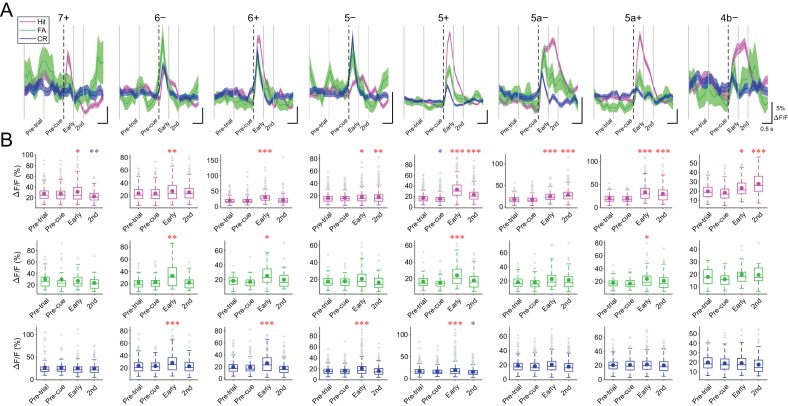
Task-related CF signals in all the compartments.(A) ROI-averaged ΔF/F traces from single compartments in single trials were classified by trial types and averaged across sessions and animals. Thick colored lines represent mean and the shadings represent s.e.m. Vertical dashed lines represent cue onset, and gray solid lines represent the edges of response windows. (B) Averaged ΔF/F value within each response window per trial for each trial type pooled across sessions and animals ( 7+, n = 5 mice, 195, 30, and 155 trials for hit, FA, and CR trials; 6−, n = 6 mice, 305, 41, and 245 trials; 6+, n = 10 mice, 345, 39, and 261 trials; 5−, n = 12 mice, 555, 66, and 452 trials; 5+, n = 12 mice, 644, 78, and 553 trials; 5a−, n = 10 mice, 516, 70, and 454 trials; 5a+, n = 3 mice, 304, 49, and 302 trials; 4b−, n = 2 mice, 112, 19, and 120 trials). Colored dots represent means and gray crosses represent outliers. Asterisks represent significantly positive (red) or negative (blue) differences compared with pre-trial ΔF/F. One-way ANOVA with repeated measures followed by post-hoc Tukey’s test: *p<0.05, **p<0.01, ***p<0.001. (A,B) Only trials without appreciable licking (lick rate <1 Hz) during pre-trial period are included in the analyses.10.7554/eLife.47021.023Figure 4—figure supplement 1—source data 1.Datasets used to create Figure 4—figure supplements 1 and 3.